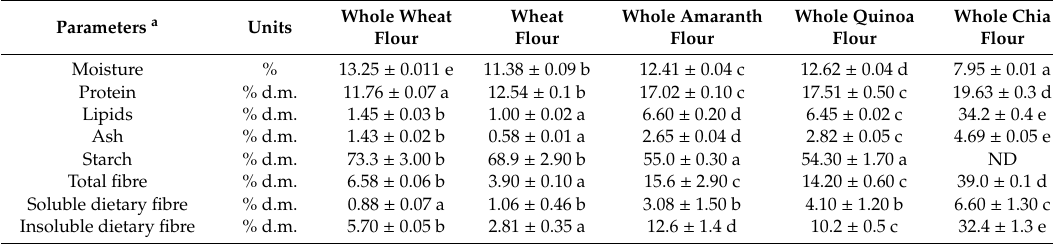
Table 2. Chemical composition of raw